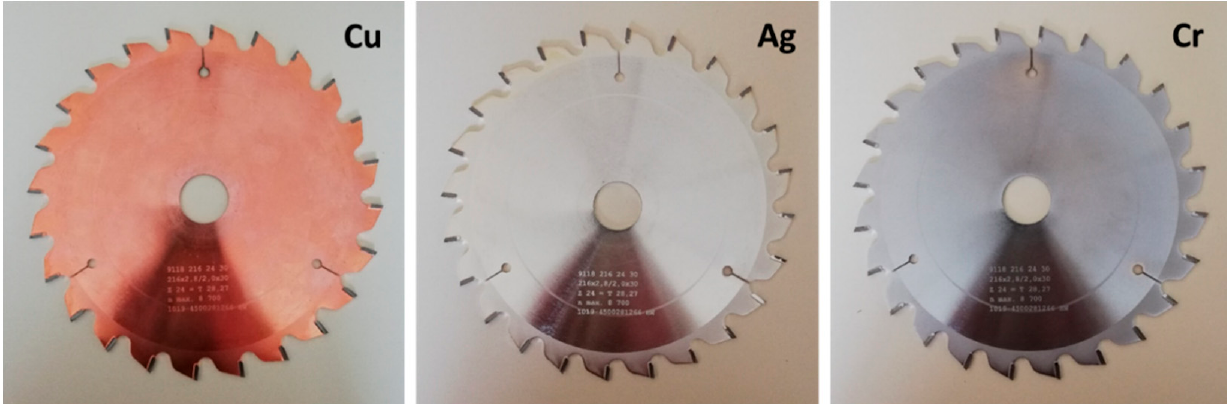
Figure 2. Circular sawing blades with 24 teeth and a base body made from industrial tool steel. Except for a reference blade, the base bodies were electroplated with either cupper (Cu), silver (Ag), or chromium (Cr).